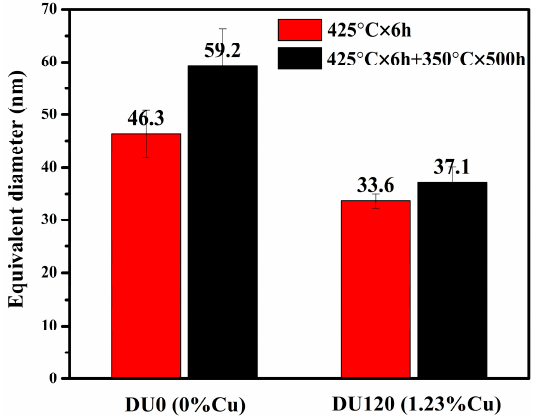
Figure 12. The comparison of the dispersoid size before and after a long-term thermal holding at 350 °C/500 h.